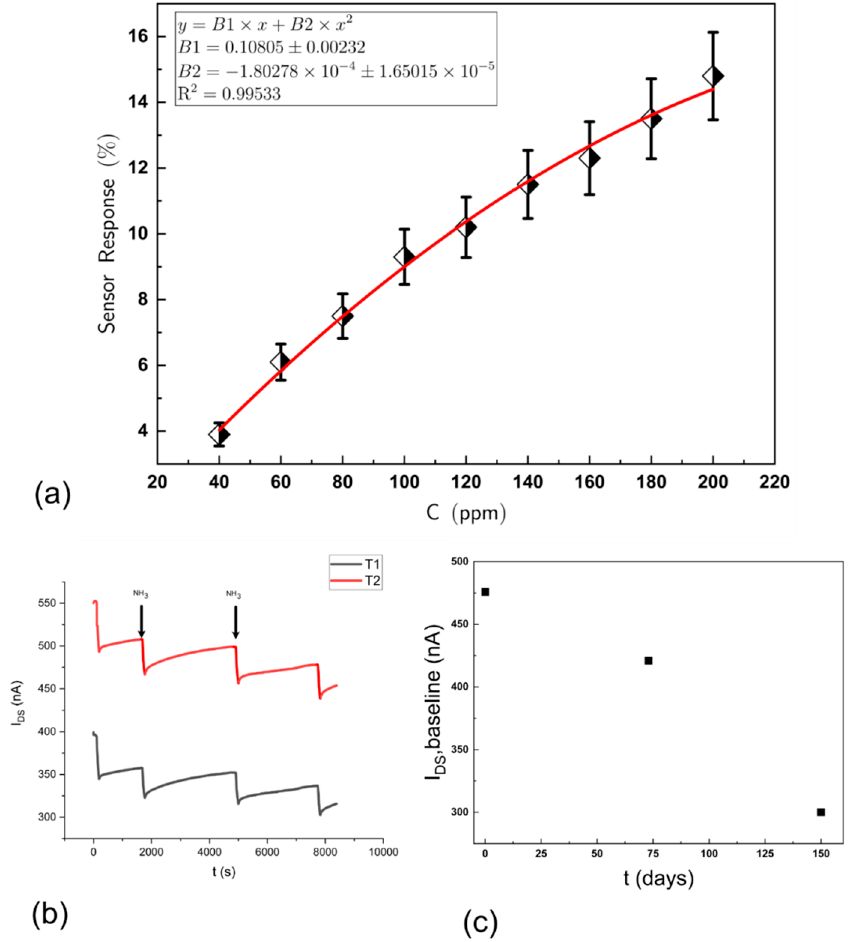
Figure 5. ( a ) Concentration–response curve for ammonia between 40 and 200 ppm. This is best fitted by a second order polynomial equation; ( b ) raw data responses from two OFET devices to repeated exposure to ammonia; ( c ) baseline I DS for one device monitored over 5 months showing a decrease in current but a still usable device after this period.